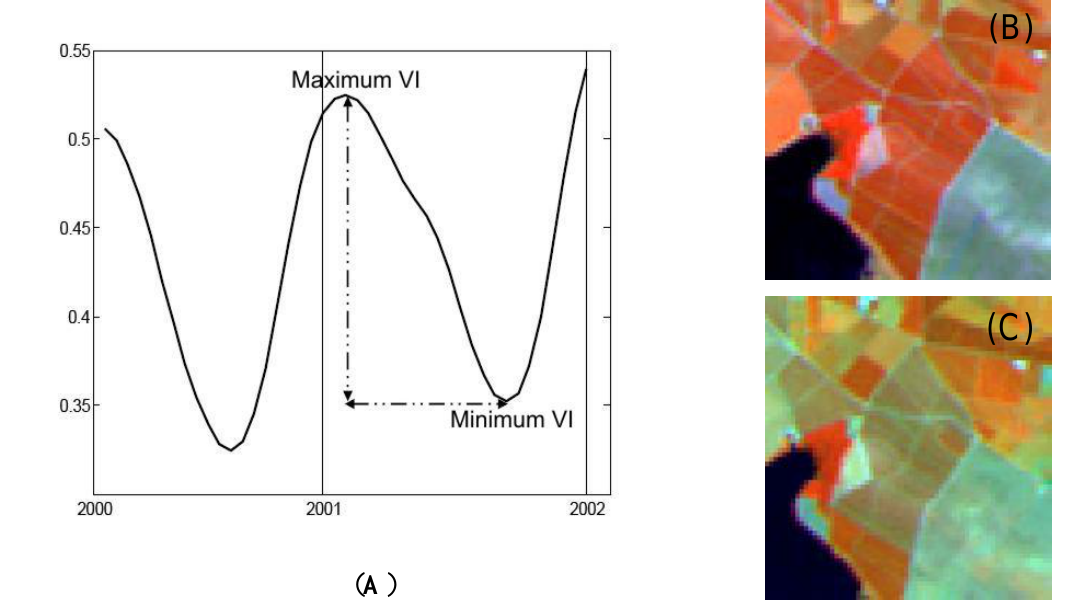
Figure 4. Annual variation of vegetation indices for the selected pixels ( A ). Standard crop with the maximum vegetation index value for March ( B ) and minimum vegetation index for August ( C ) on Image TM/Landsat